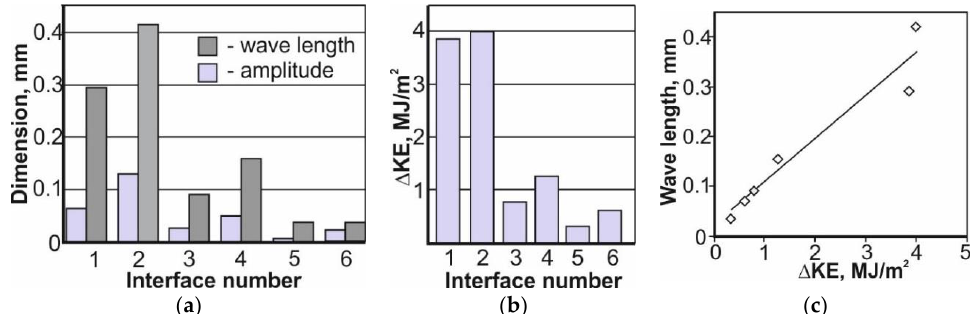
Figure 3. Amplitude, wave length ( a ), and kinetic energy loss ( Δ KE ) ( b , c ) for different interfaces.